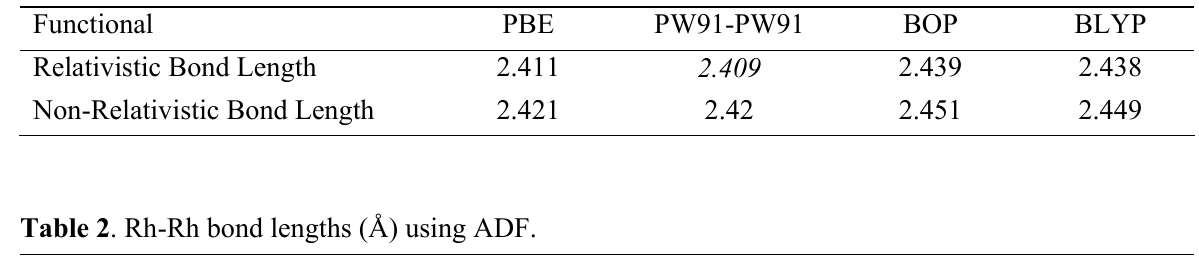
Table 1 . Rh-Rh bond lengths (Å) using DMOL3.